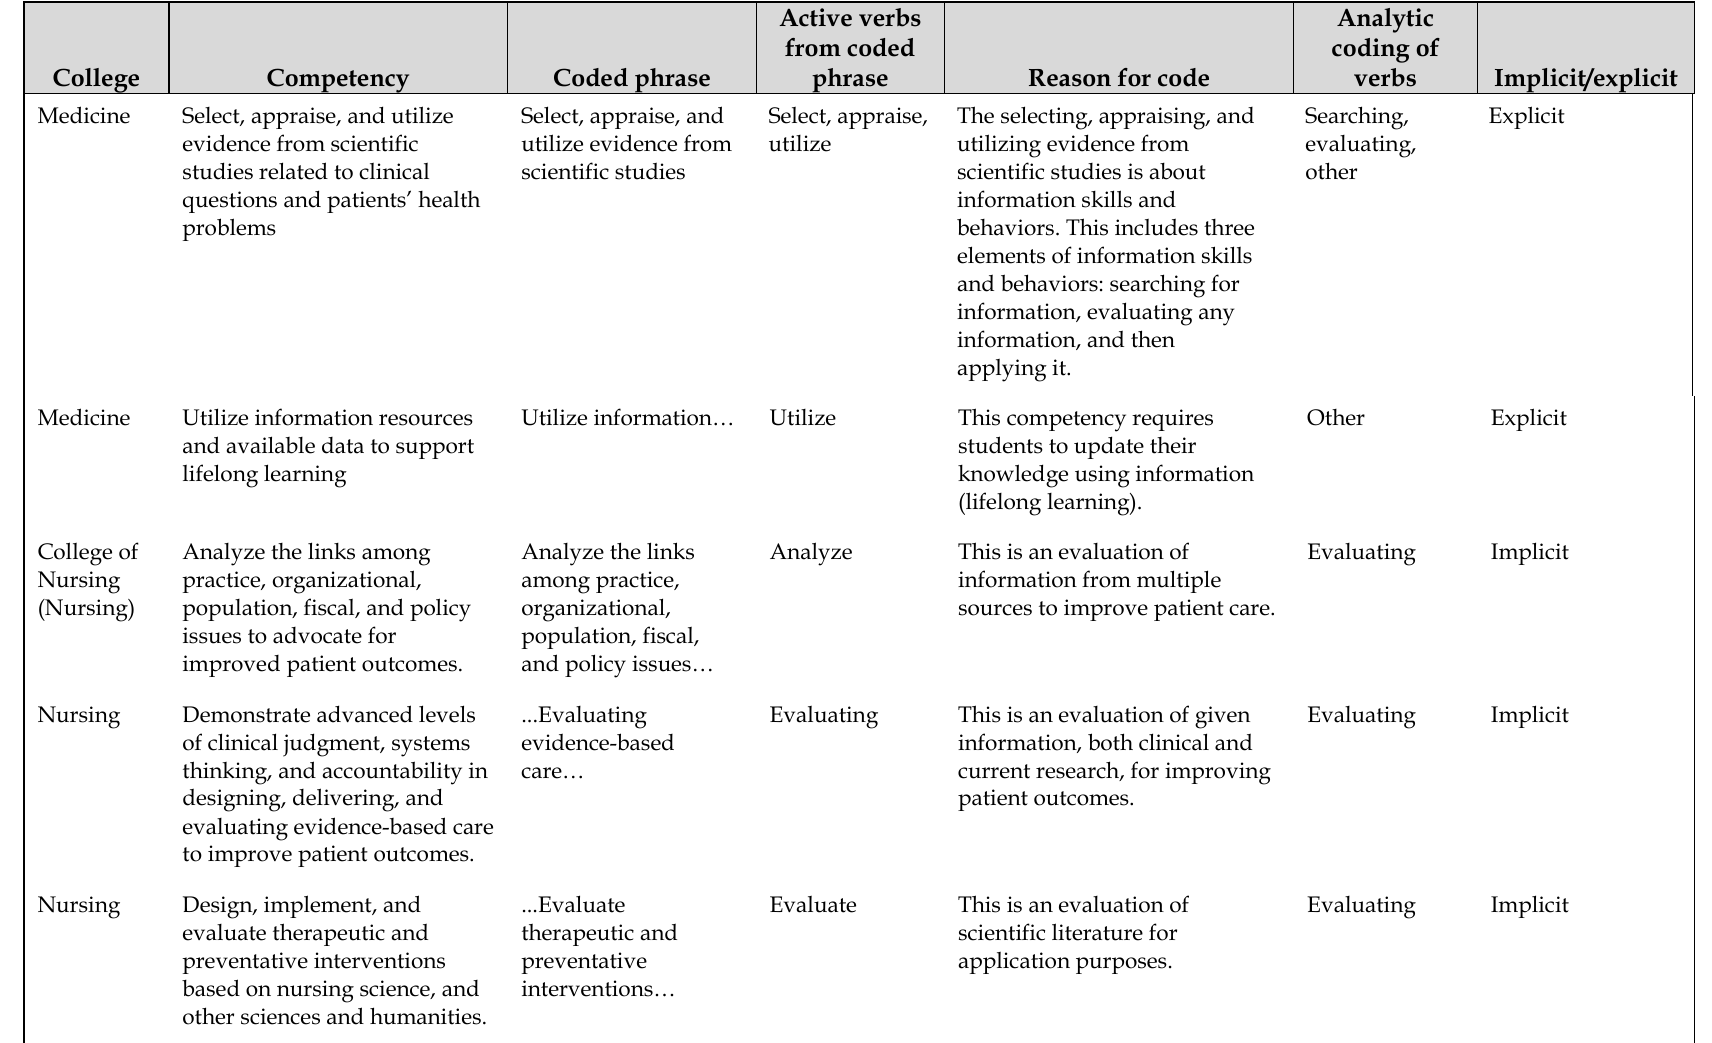
Table 2 Competencies with implicit or explicit information skills and behaviors